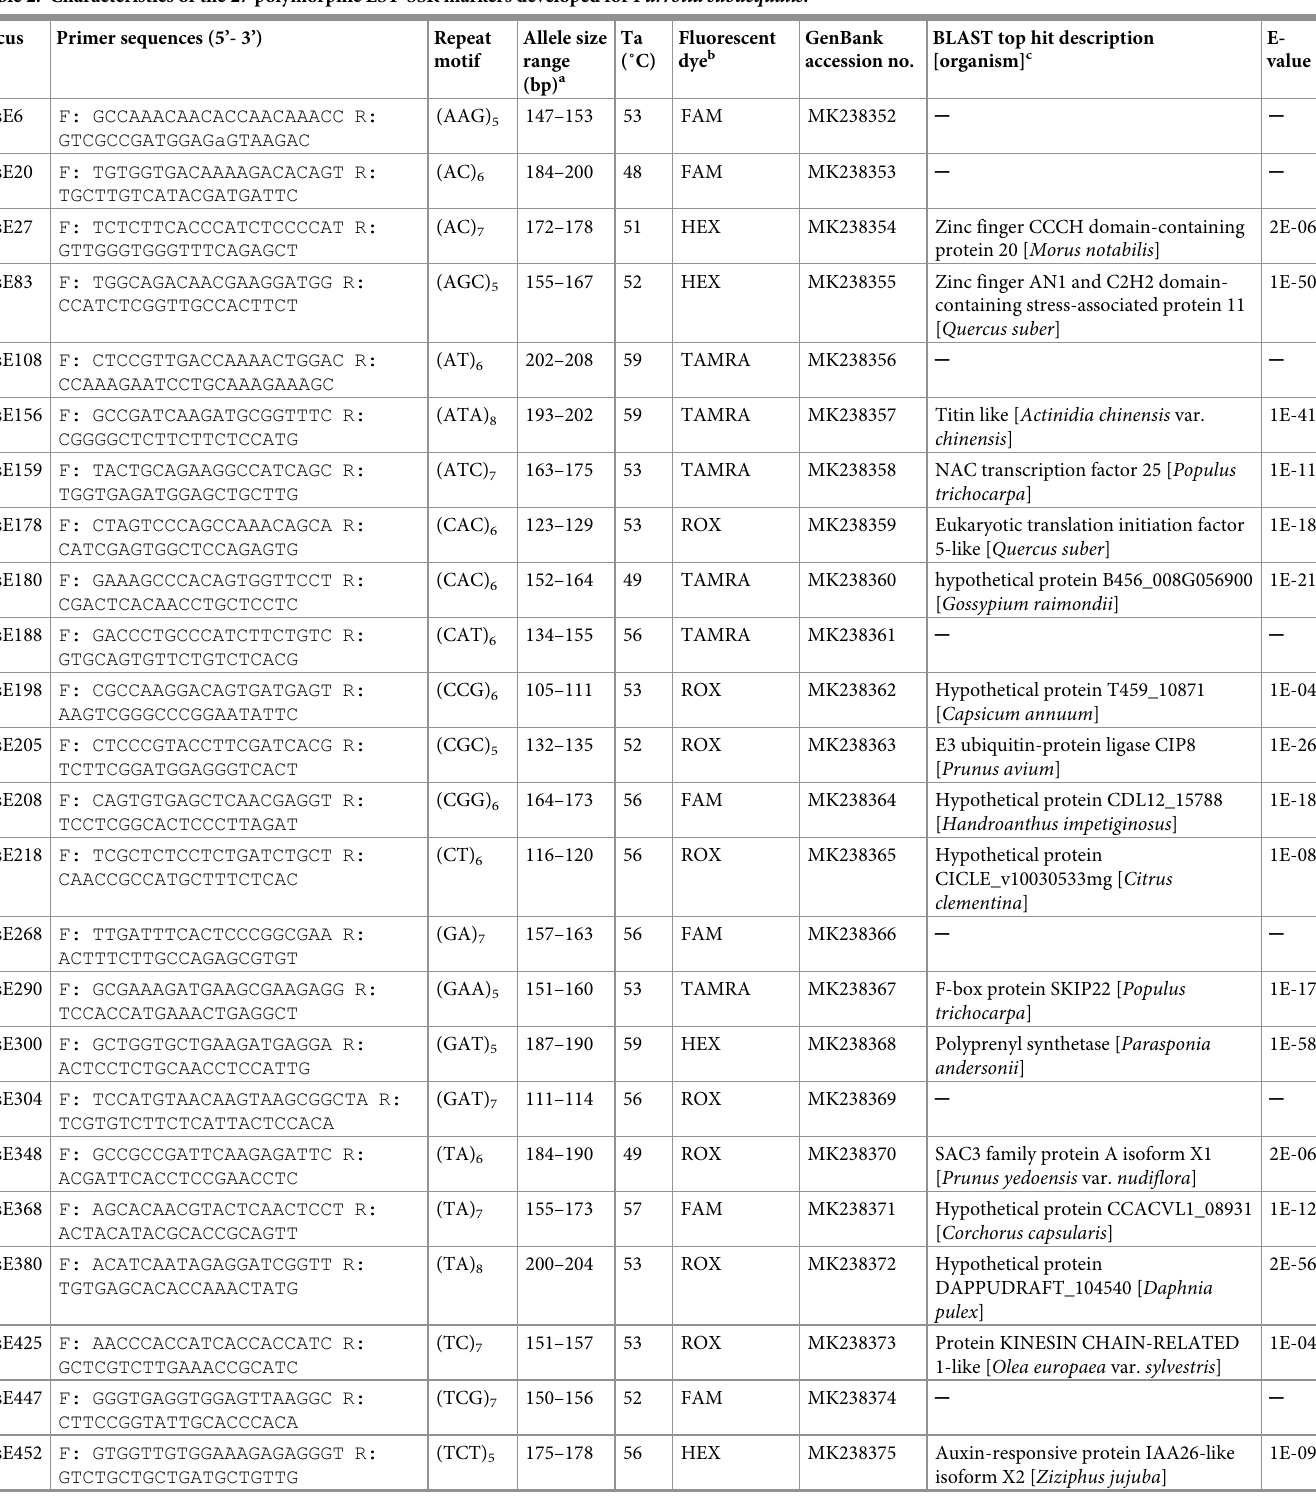
Table 2. Characteristics of the 27 polymorphic EST-SSR markers developed for Parrotia subaequalis .